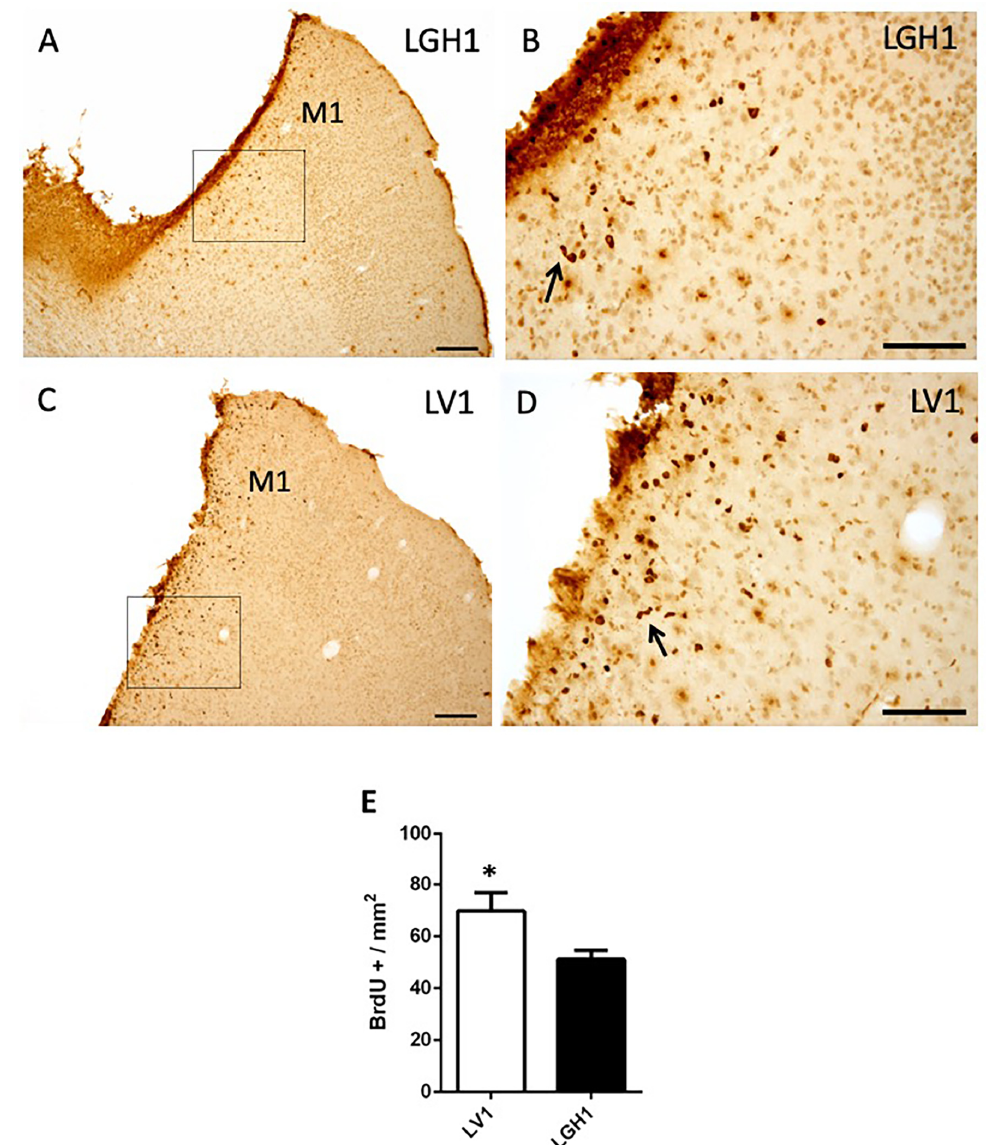
Figure 3. Cell proliferation in the perilesional motor cortex of animals sacrificed at 25 dpi. BrdU immunolabeling in the perilesional primary motor cortex (M1) of animals treated with GH ( A , B ) or vehicle ( C , D ), immediately after cortical ablation and sacrificed at 25 dpi. ( B , D ) are a magnification of ( A , C) , respectively. Coronal sections at + 2.52 mm from Bregma. The black arrows in B and D point out BrdU + cells forming clusters (or chains). Scale bars: 200 µ m ( A , C ), 100 µ m ( B , D ). ( E ) Quantification of the total number of BrdU + cells in the perilesional M1 motor cortex of animals treated with GH or vehicle. A significant increase in BrdU-labeled cells in animals treated with vehicle compared with animals treated with GH was found (Mean + SEM; n = 2). * p < 0.05.